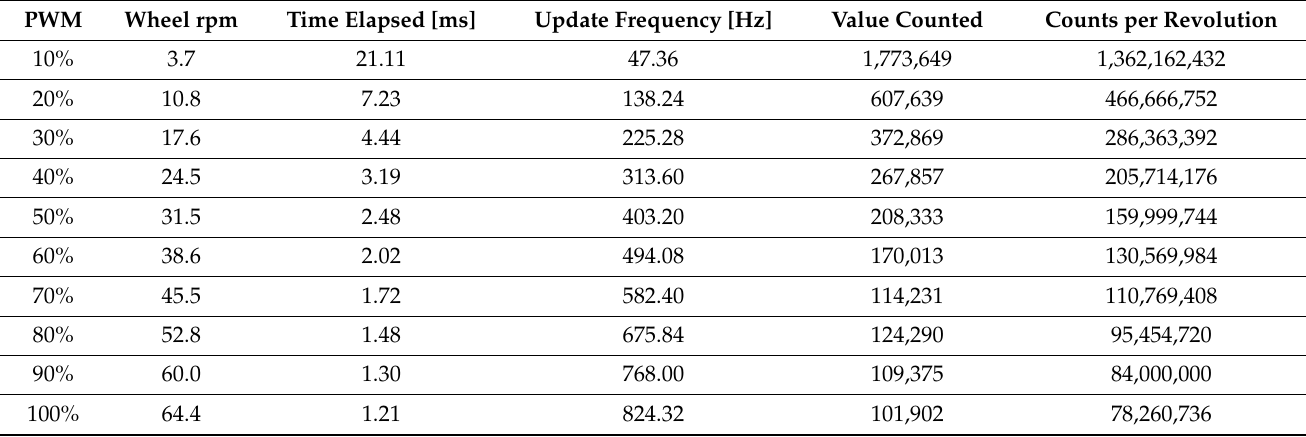
Table 2. Example encoder information obtained when applying a specific PWM to the BLDCM.